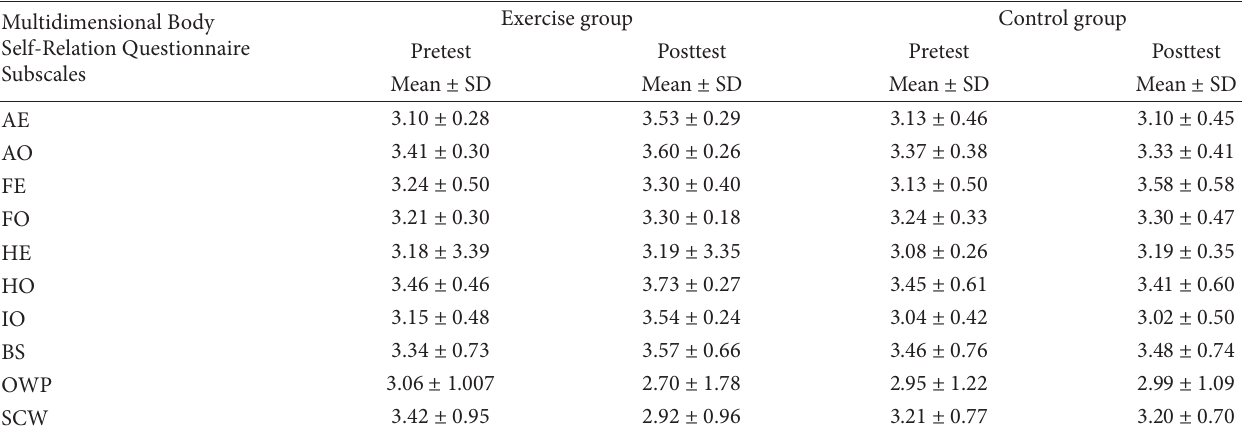
Table 2: Pretest and posttest, mean and standard deviations of body-image